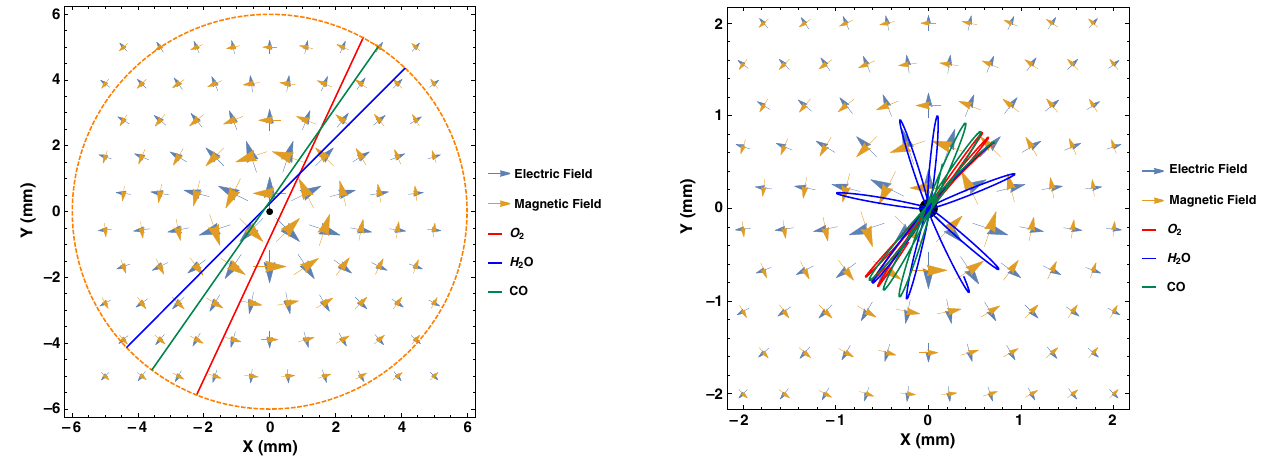
FIG. 12. The motion of neutral oxygen, water and carbon FIG. 10. The motion of neutral oxygen, water and carbon monoxide molecule flakes initially at rest, initially 1 mm from the monoxide molecules initially at 1 mm from the beam with a thin-wire beam, and subjected to the electromagnetic beam field, thermal velocity corresponding to a temperature of 15 K, and in the transverse plane, for a pipe temperature of about 15 subjected to the electromagnetic field of a beam, in the transverse ¼ 62 m = s for O plane. The initial thermal velocities were v 2 , th v ¼ 82 m = s for water, and v ¼ 67 m = s for CO. Note the th th assumption of perfect elastic collisions with the chamber wall.